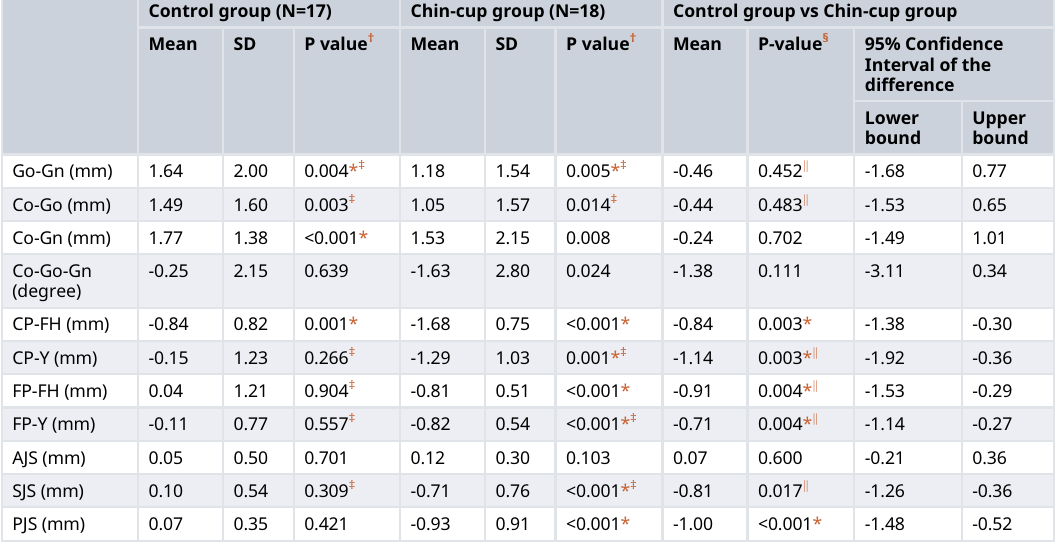
Table 6. Descriptive statistics of the cephalometric changes that occurred in each group (T2-T1) as well as the p-values of significance tests.